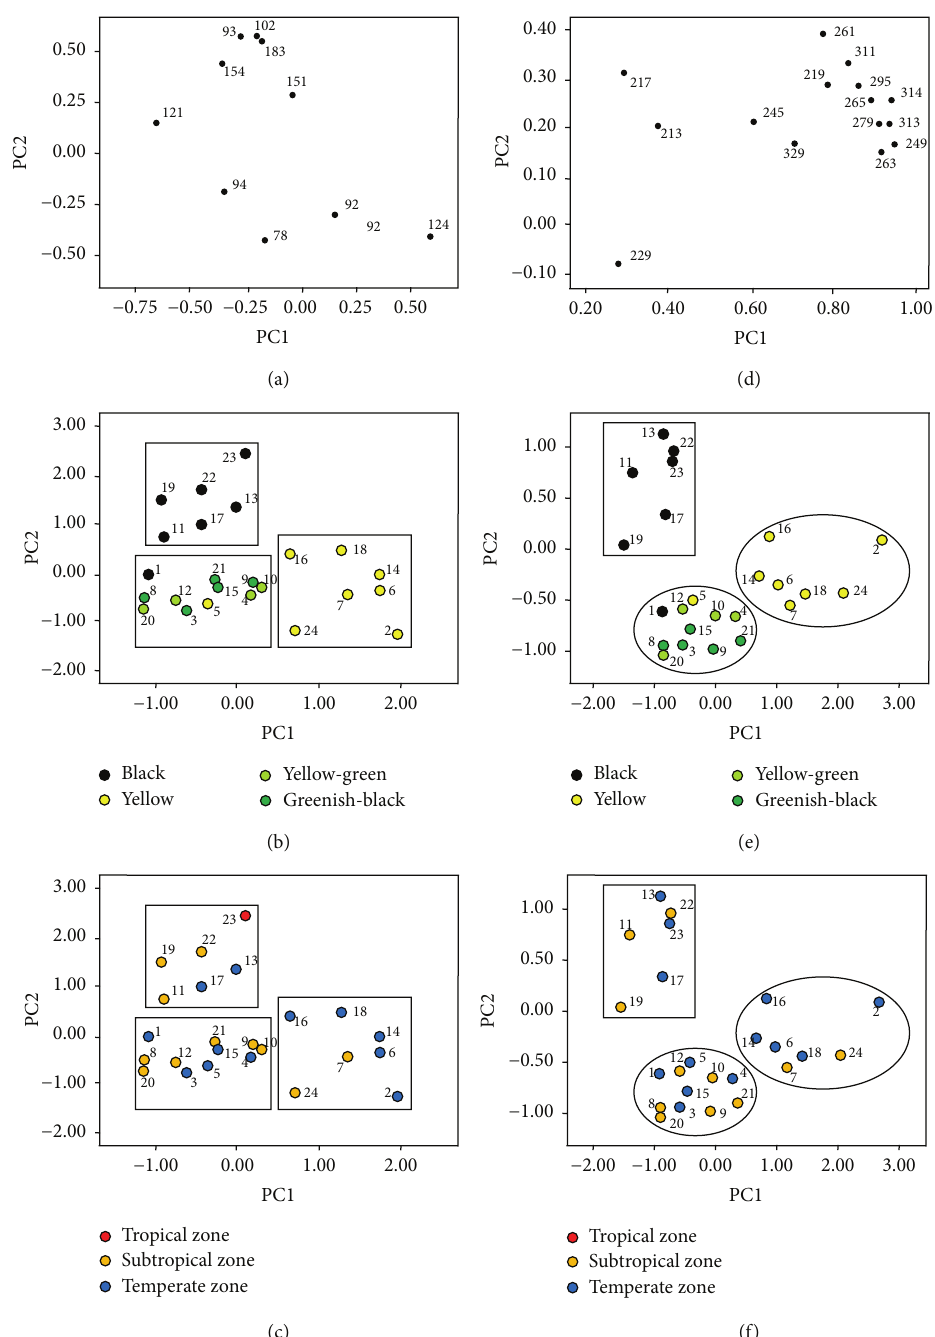
Figure 2: PCA analysis of SDAPCI-MS fingerprints. PCA loading plots (ions) for 70–500 m/z (a) and 200–350 m/z (d). PCA score plots for SDAPCI-MS fingerprints of propolis and their colors for 70–500 m/z (b) and 200–350 m/z (e). PCA score plots and their climatic zones for 70–500 m/z (c) and 200–350 m/z (f). For (a) and (d), the numbers of spots mean the m/z of the ions. For (b), (c), (e), and (f), the numbers are their sample number. See Table 1 for characteristics of the